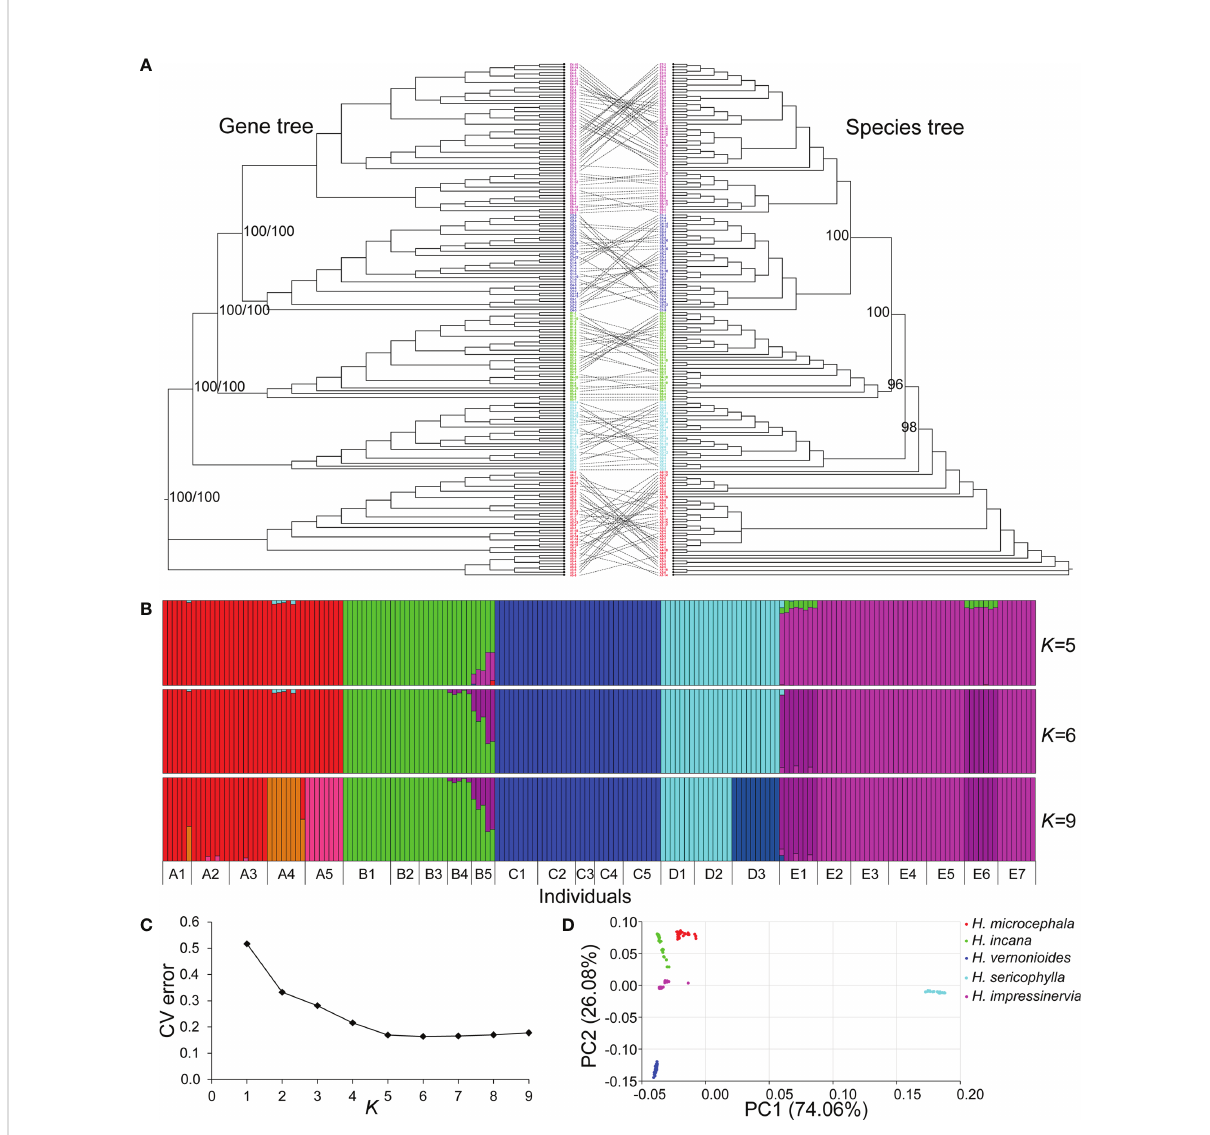
FIGURE 3 Phylogenetic relationships and genetic structure of species in the genus Heteroplexis . (A) Gene tree reconstructed based on the maximum likelihood (ML) method and species tree reconstructed based on the SVDQuartets method. (B) Population structure analysis using Admixture. (C) Cross-validation (CV) errors for K = 1 – 9. (D) The fi rst two dimensions of principal component analysis (PCA) based on genome-wide SNP